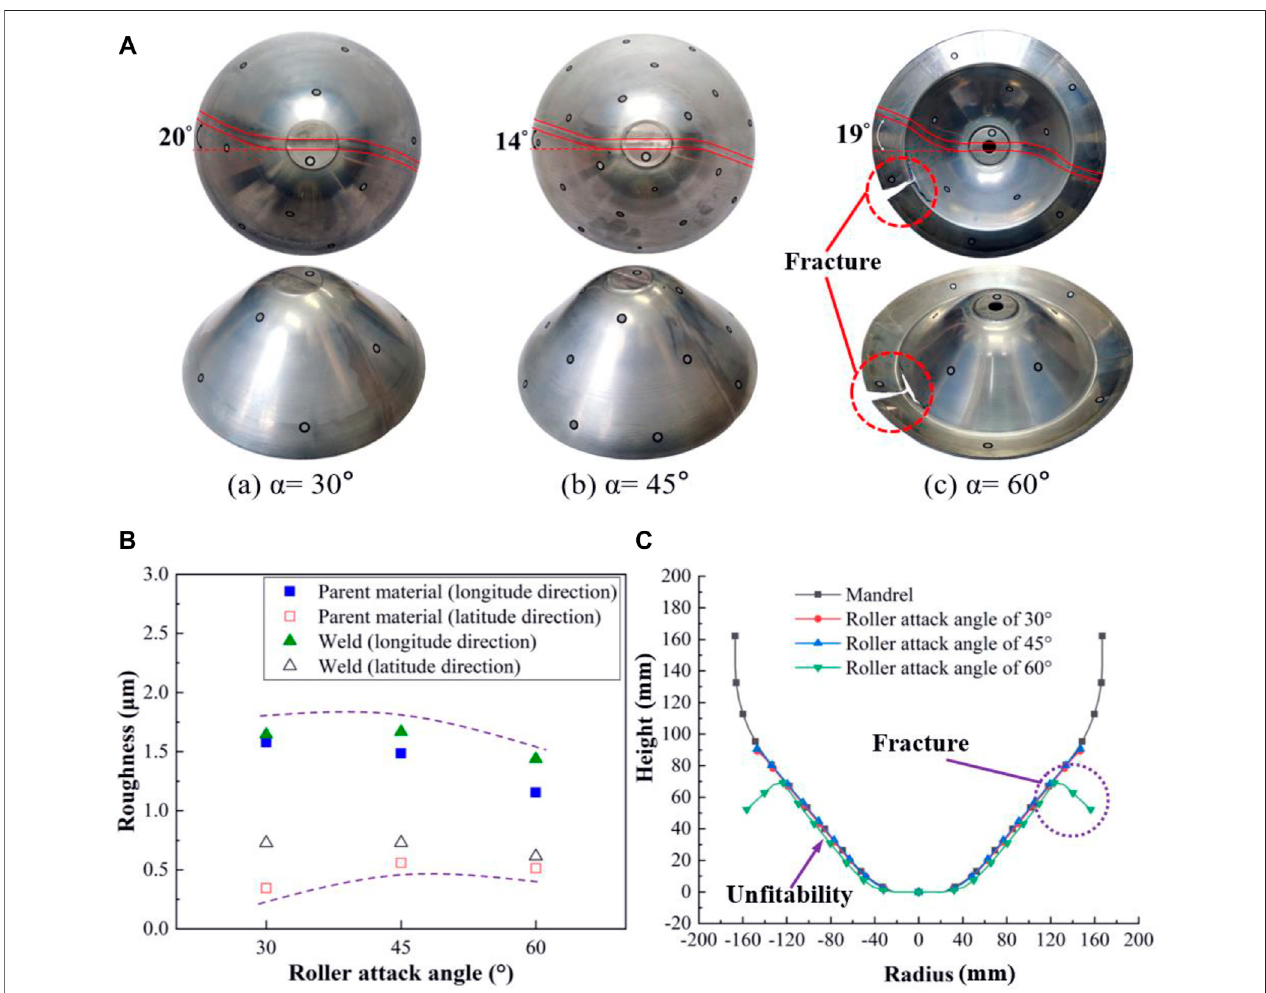
FIGURE 6 | Experimental results: (A) top and oblique views of spun parts under the roller attack angle of (a) α (cid:1) 30 ° , (b) α (cid:1) 45 ° , and (c) α (cid:1) 60 ° ; (B) surface roughnesses of spun parts and (C) forming pro fi le of spun parts.